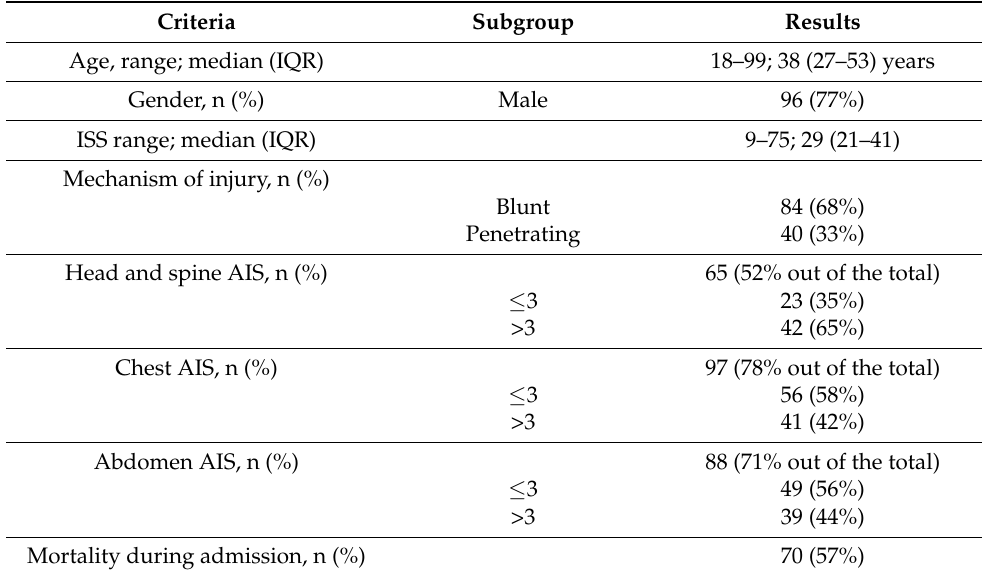
Table 1. General features of the 124 patients who had an activated massive transfusion protocol at Tampa General Hospital between 2015 and